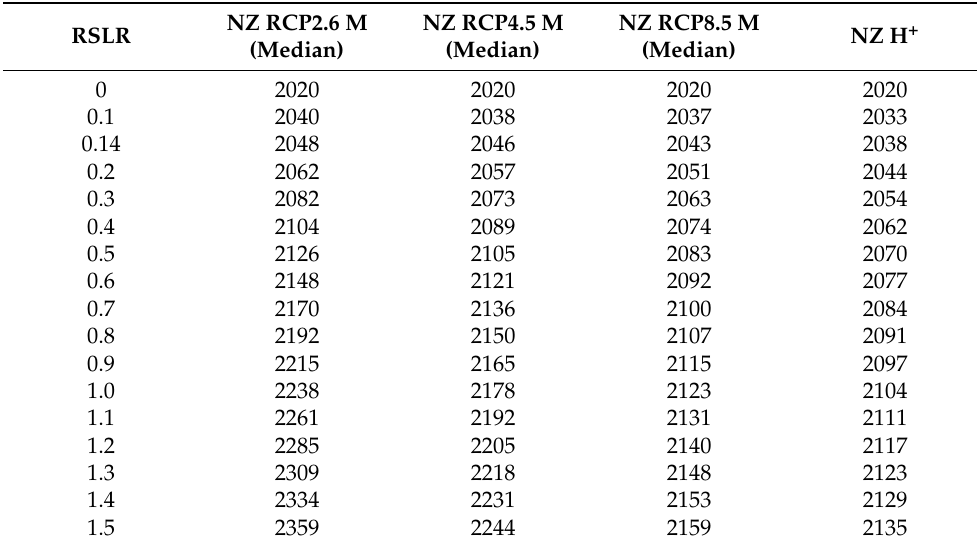
Table 3. Approximate years, from possible earliest to latest, when specific sea-level rise increments (metres above 2020 MSL) could be reached for various projection scenarios of sea-level rise for the wider New Zealand region (adapted from